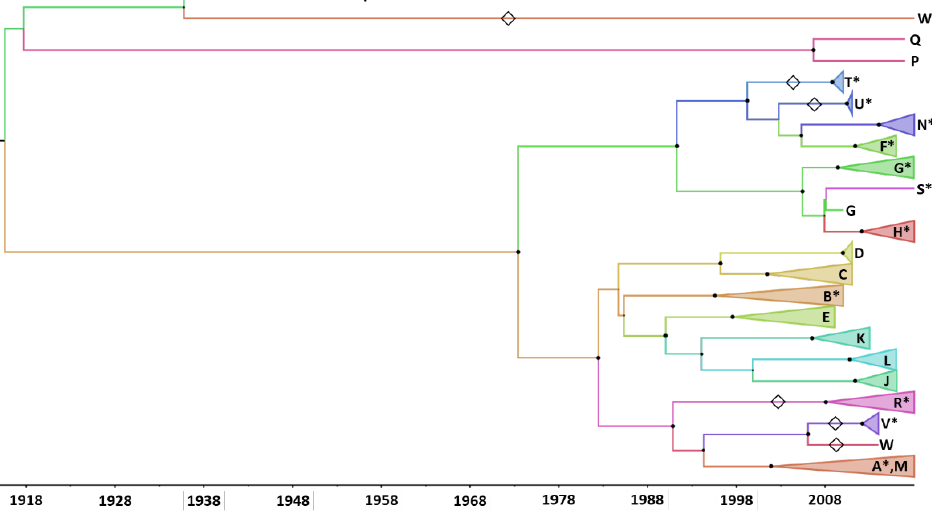
Figure 3. Genetic pool of recombinant forms (RFs) identified among coxsackievirus A6 genomes. The 3Dpol gene was derived from a dataset of 760 (near full) genomes including the 213 CVA6 genomes determined in this study, and was analysed with a Bayesian method. Large full black circles at nodes indicate posterior probability values > 0.9 representing distinct RFs. The clades designated with letters A to Q correspond to the previously identified RFs. Open diamonds along branches indicate RFs previously unreported before this study. The 11 clades labelled with an asterisk include sequences reported in this study. For more clarity, the sequences within each clade were collapsed. Table 3. Yearly distribution of recombinant forms (RFs) among coxsackievirus A6 complete ge- nomes associated with hand-foot-and-mouth disease/herpangina in France.